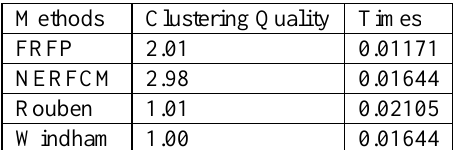
Table 12 Averages of 100 trials using proximity matrices similar to proximity matrix 3 but with 72 objects each time.